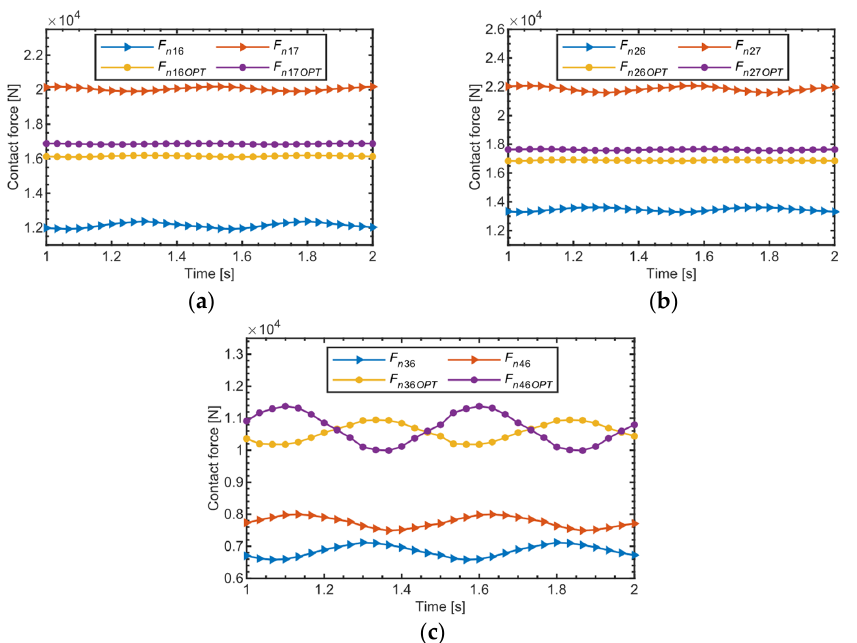
Figure 23. Meshing force of each gear pair by finite element method: ( a ) Input Gear 1; ( b ) Input Gear 2; ( c ) idlers.